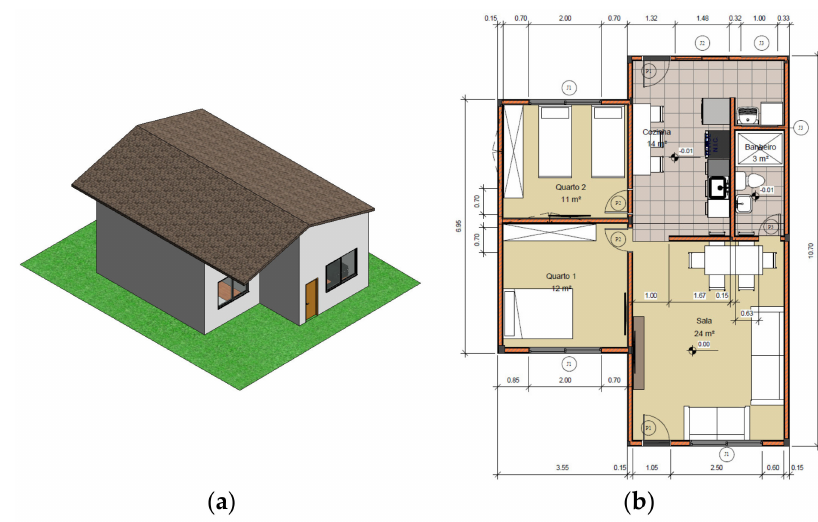
Figure 2. The low-income house 3D modeling ( a ) and floor plan ( b